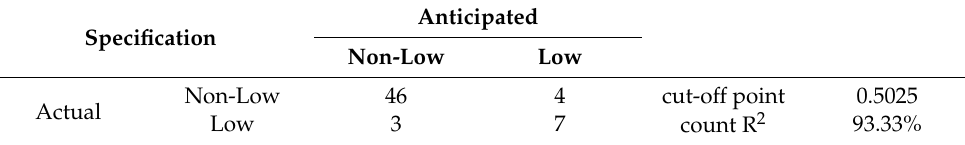
Table 7. The contingency table for the low vs. rest model. Specification